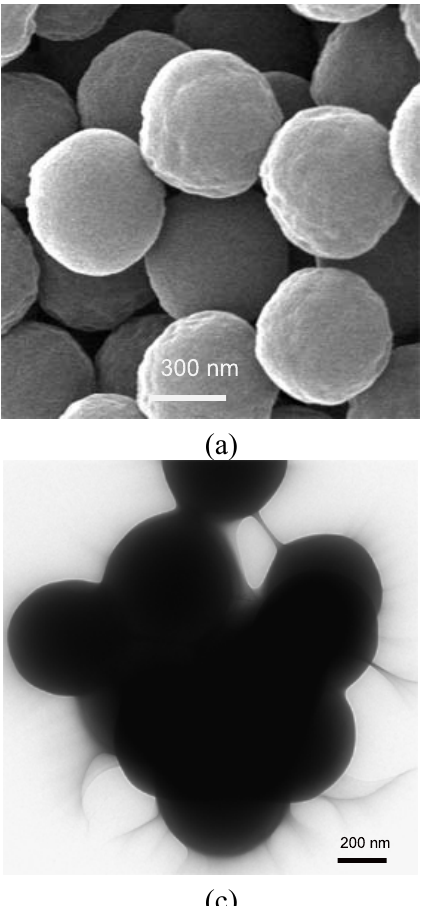
Figure 1. (a,b) SEM and TEM micrographs of the latex particles functionalized with a copolymer layer carrying ATRP initiator and (c,d) the grafted brushes of poly( N -isopropylacrylamide) from the surface of the functionalized particles using ATRP